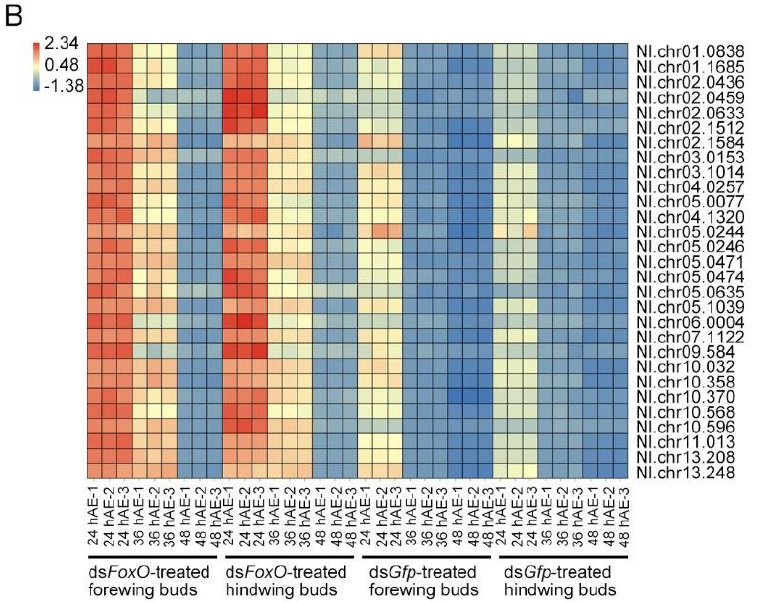
Figure 11. Heatmap of DEGs in cell cycle and DNA replication pathways. Transcripts with fold change ≥ 2 and FDR < 0.05 were subjected to heatmap